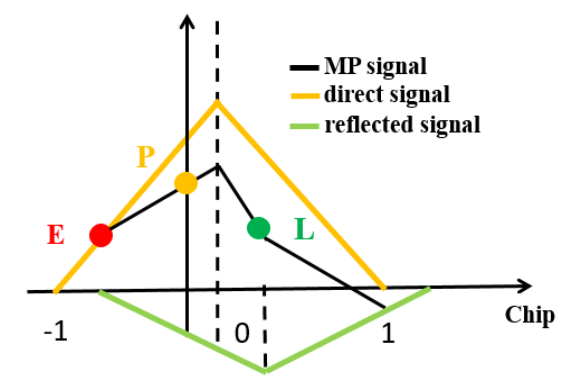
Figure 1. Correlators outputs of the GNSS NLOS/MP/LOS signals (Xu et al., 2019; Jiang et al., 2022)